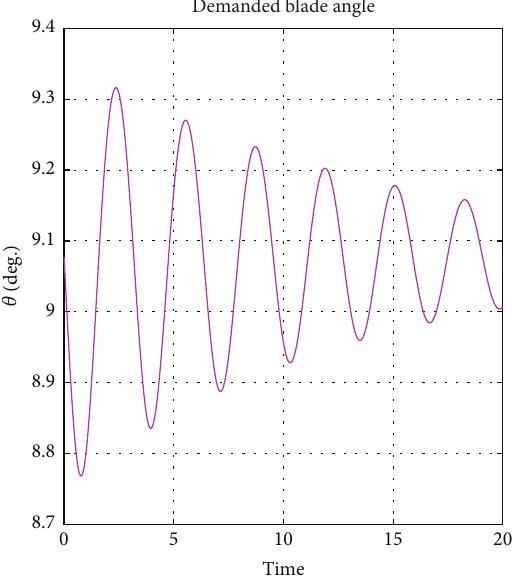
Figure 8: Demanded blade angle corresponding to Figure 7.